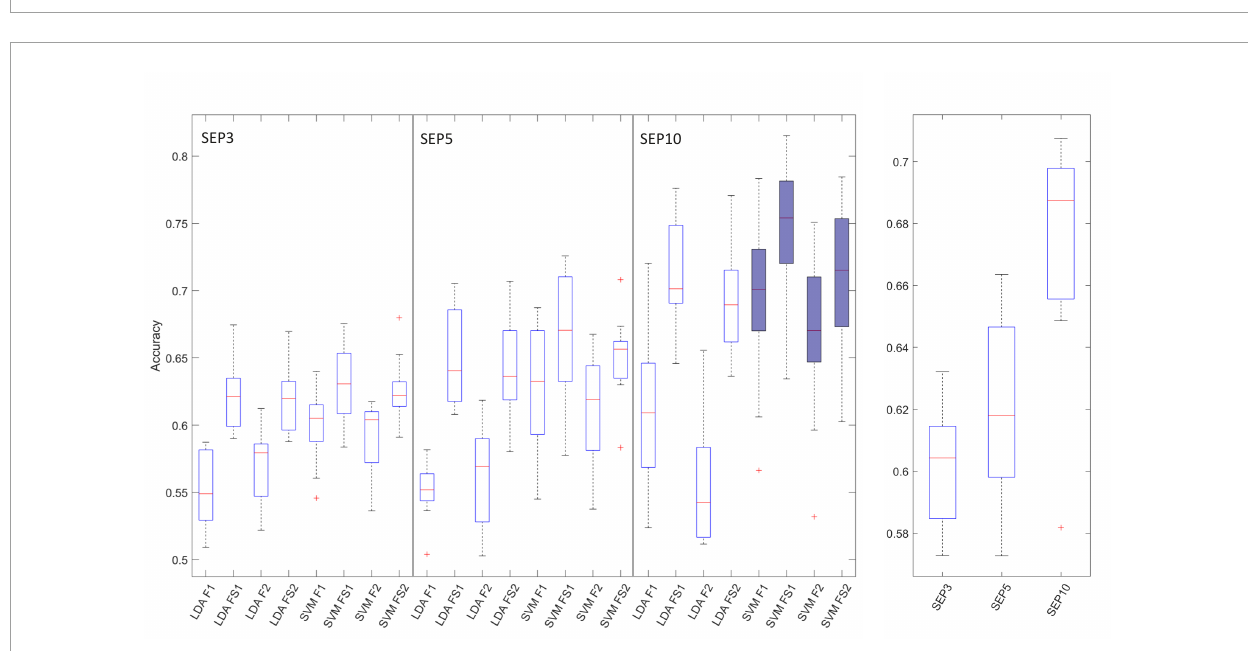
FIGURE4 Boxplots of the BCI performance (accuracy) results over all channels. The left graph shows results for all tested combinations of classifiers (LDA and SVM) and feature extraction/selection methods (F1, F2, FS1, and FS2). Left graph is divided into 3 groups of boxplots (SEP3, SEP5, and SEP10 results), from left to right, respectively. Combination of SVM, SEP10 and 4 feature extraction methods selected for further analysis (last 4 boxplots) are filled with blue color. The right graph shows grouped result over 3 trial-averaging options (SEP3, SEP5, and SEP10). The horizontal line denotes median, boxes are interquartile ranges, whiskers show minimum and maximum values, and outliers are marked with red